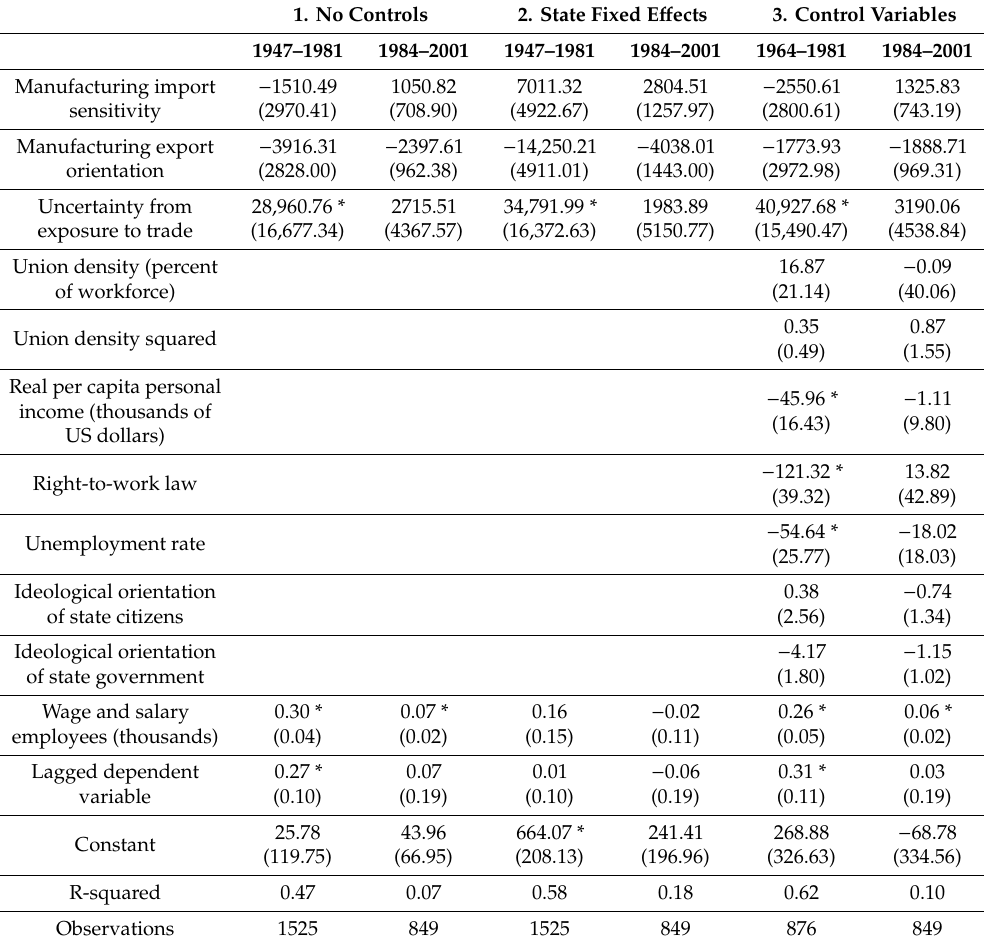
Table A4. Models from Table 2 with Alternative Indicator of Trade-Related